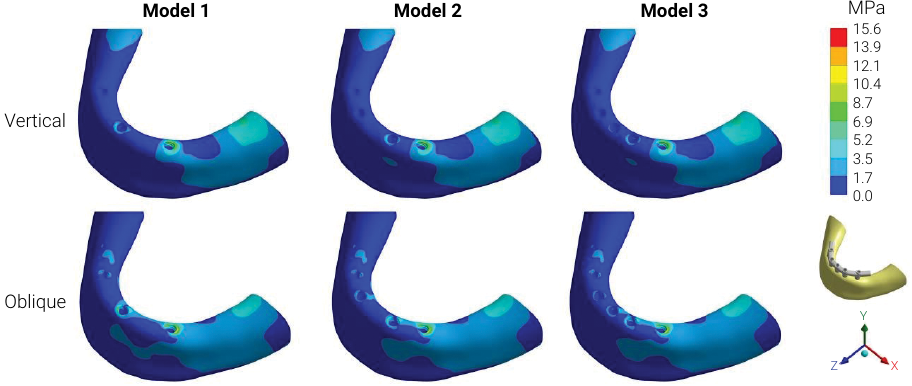
Figure 2. The stress field by vertical and oblique loading, represented by von Mises analysis, around implant A, for the three models of full-arch prosthesis evaluated.